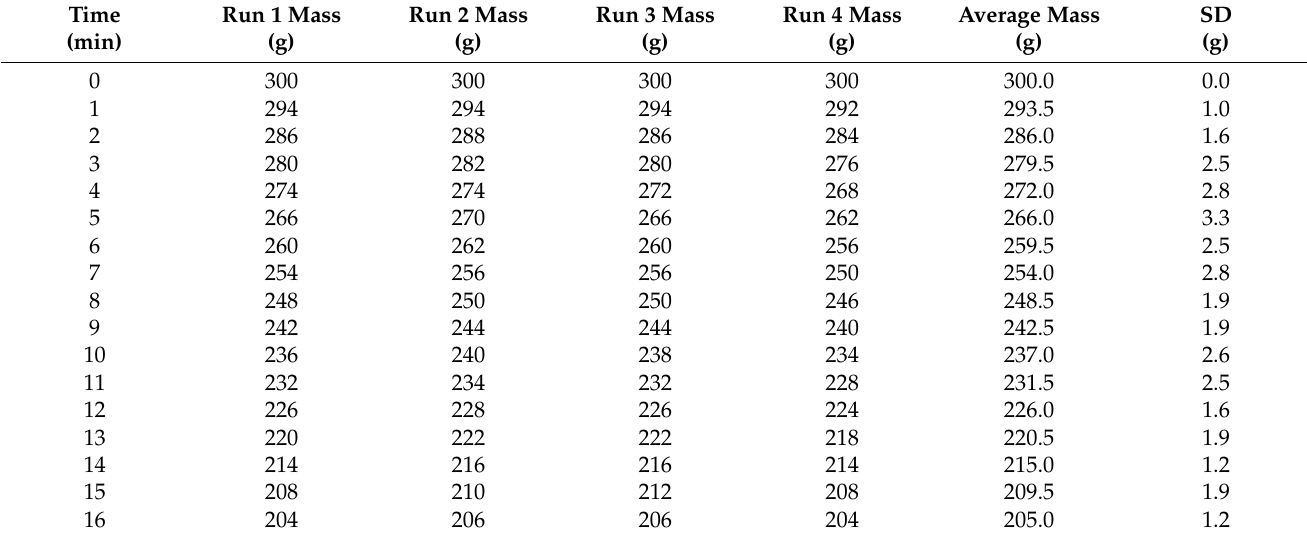
Table A3. Configuration C mass